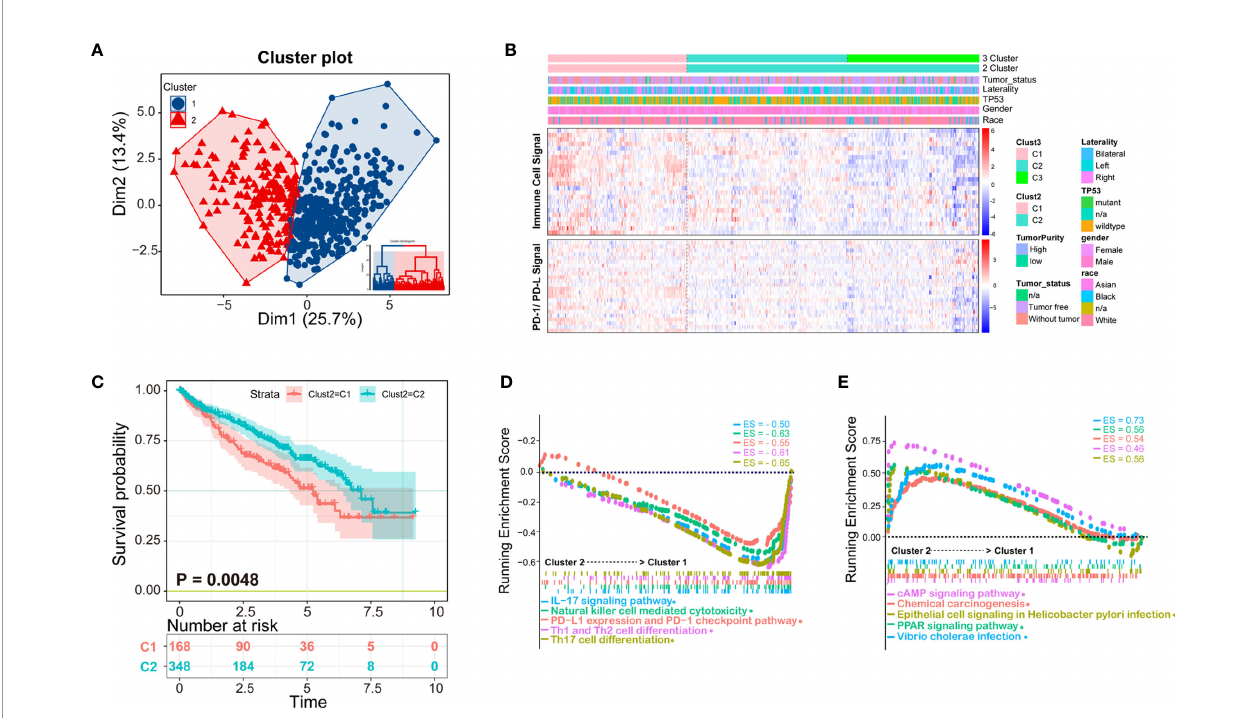
FIGURE 3 | K-means clustering method identi fi es patients of ccRCC with distinct immune cell in fi ltrates. (A) Patients could be clustered into two groups (Cluster 1 and Cluster 2) with distinct immune cell pro fi les by K-means method; (B) The clustering heatmap of immune cell in fi ltrates and related clinical parameters. The heatmap of two clusters is obviously distinct, among which Cluster 1 is immune-high, and cluster2 is immune-low. The molecules related to the PD-1/PD-L1 signaling pathway are consistent with the two subtypes of patients; (C) The Kaplan-Meier overall survival results of two clusters, Cluster 1 has a better prognosis than Cluster 2; (D, E) Gene Set Enrichment Analysis (GSEA) analysis of the two clusters, in which the immune signal of Cluster 1 is higher than that of Cluster 2. The ES (enrichment score) represents the degree to which a gene set is overrepresented at the top or bottom of the ranked gene